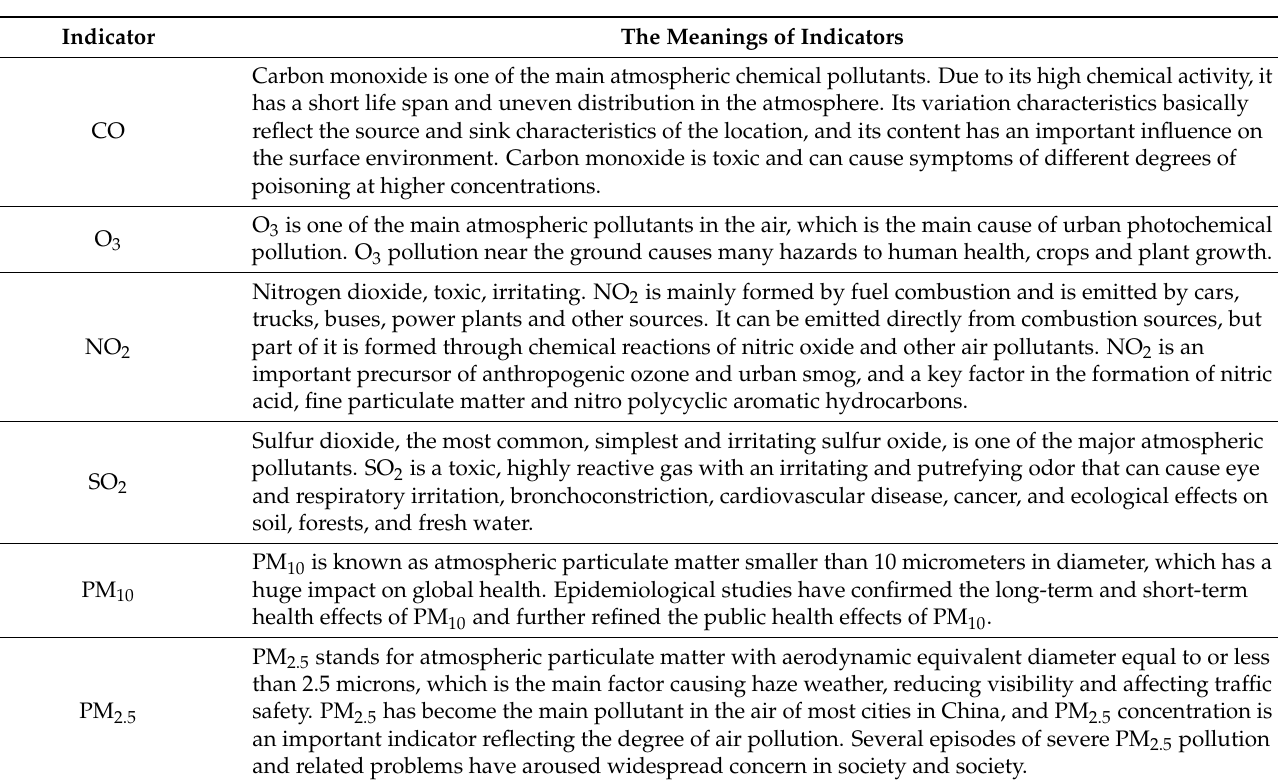
Table 1. The meanings of air quality